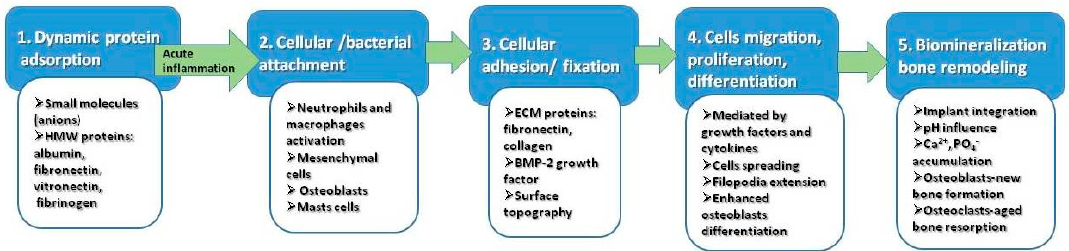
Figure 3. The main sequence of events occurring in vivo, during interaction between Ti surface and biological environment. biological